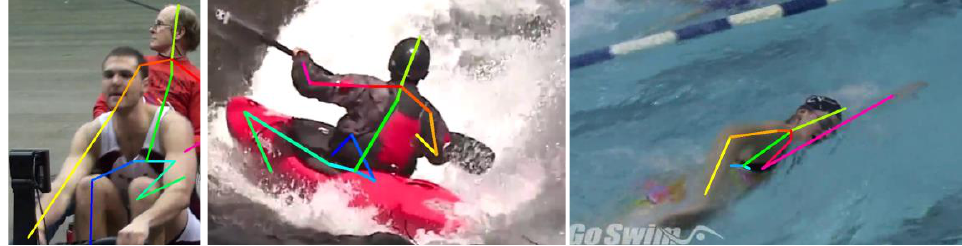
Figure 11. Failure cases caused by ( left ) overlapping people, ( middle ) cluttered background, and ( right ) severe